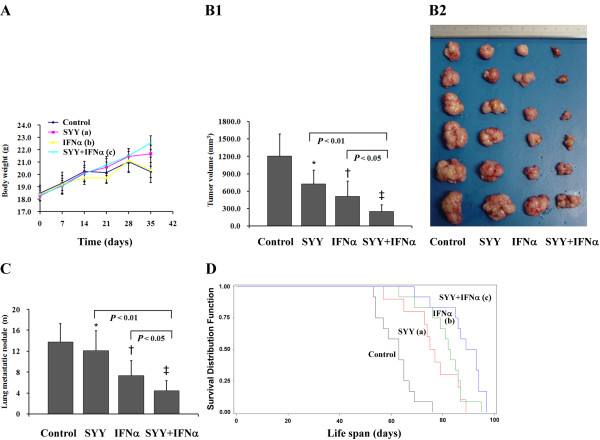
Comparison of therapeutic effect. (A) BW curves. The combined therapy noticeably minimized the BW loss. aP < 0.01, bP > 0.05, cP < 0.001 compared with control at the end of 5 weeks of treatment. (B1) Tumor volumes. Tumor volumes in the control, SYY, IFN-α, and SYY + IFN-α groups were 1205.2 ± 581.3 mm3, 724.9 ± 337.6 mm3, 507.6 ± 367.0 mm3, and 245.3 ± 181.2 mm3, respectively. *P < 0.05, †P < 0.01, ‡P < 0.001 compared with control. (B2) Tumors in different groups with decreasing tendency. Tumor inhibition rate in 4 groups was 39.9% (SYY group), 57.9% (IFN-α group), and 79.6% (SYY + IFN-α group), respectively. (C) The mean number of lung metastatic nodules in 4 groups. Six mice from each group were humanely killed 48 hours after the final treatment. Paraffin blocks of 10% buffered formalin-fixed samples of lung tissues were prepared, serial sections were cut at 5 μm, and pulmonary metastatic nodules were verified with hematoxylin and eosin stain. *P > 0.05, †P < 0.05, ‡P < 0.01 compared with control. (D) Survival curves among groups. The remaining 12 mice of each group were maintained on the designated therapies until death to determine their lifespan. aP < 0.05, bP < 0.01, cP < 0.001 compared with control. The bars indicate the means ± SD.